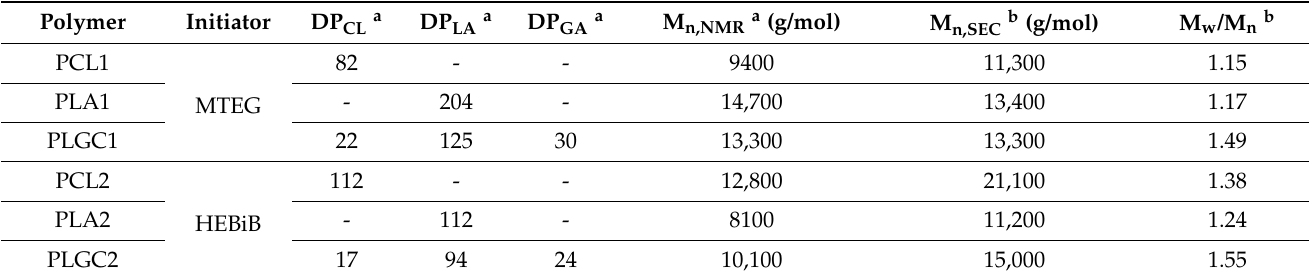
Table 1. Characterization of aliphatic polyesters.